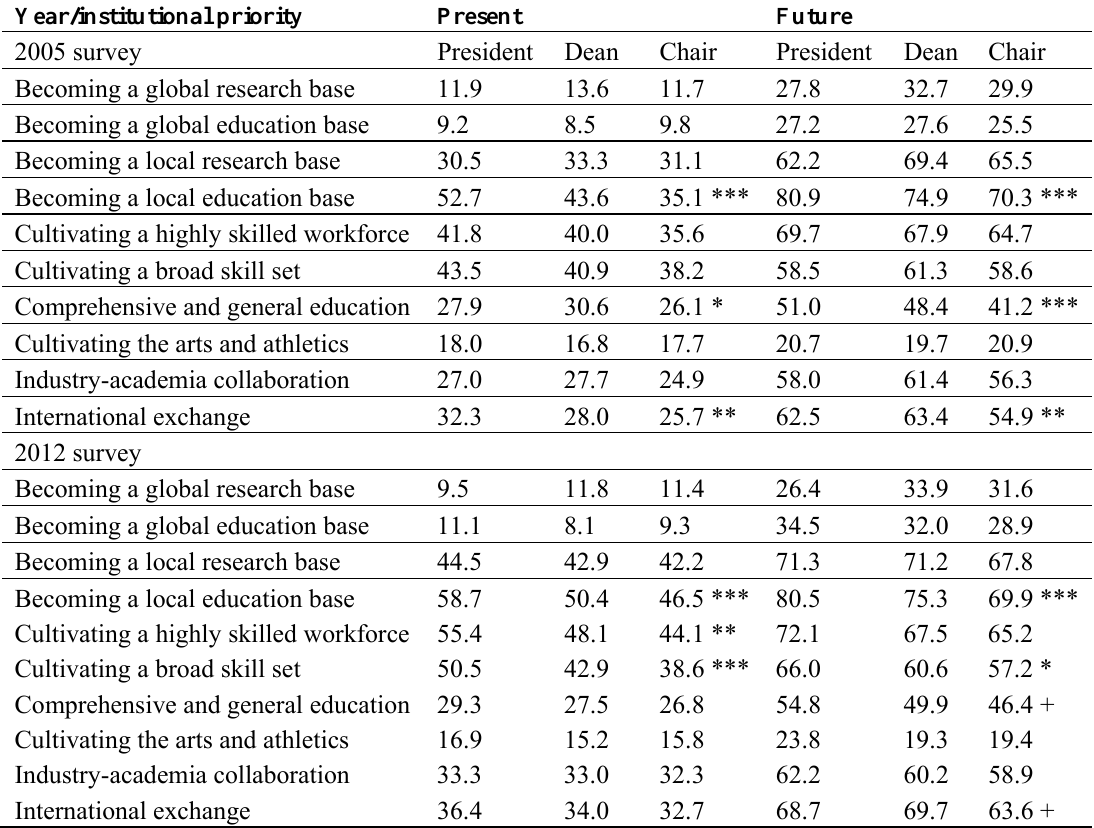
Table 3. Proportions of Japanese university executives acknowledging the listed academic priorities with positive perceptions, by managerial